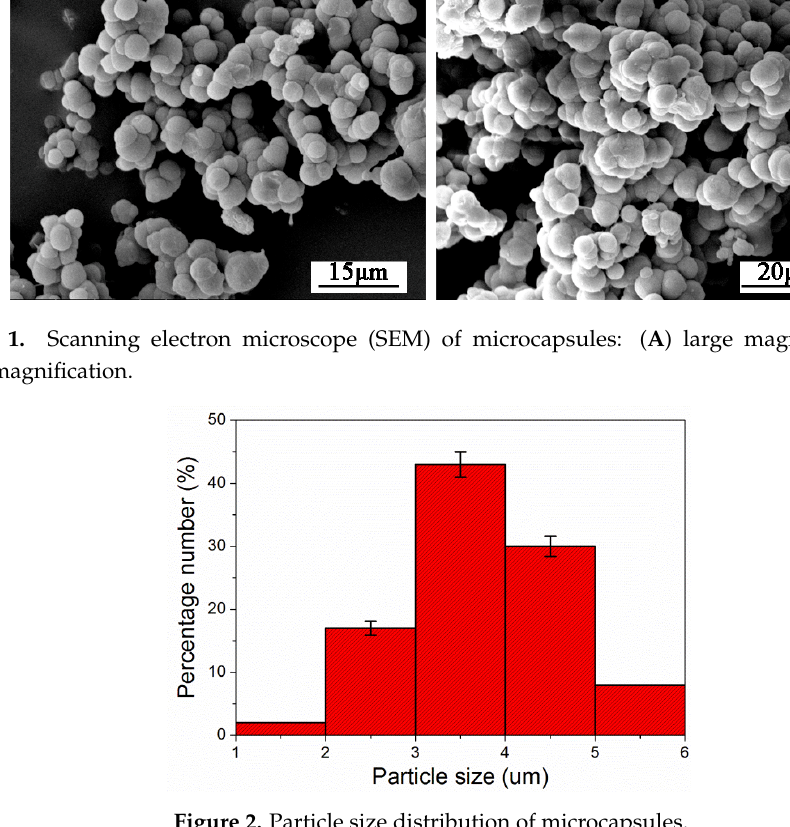
Figure 2. Particle size distribution of